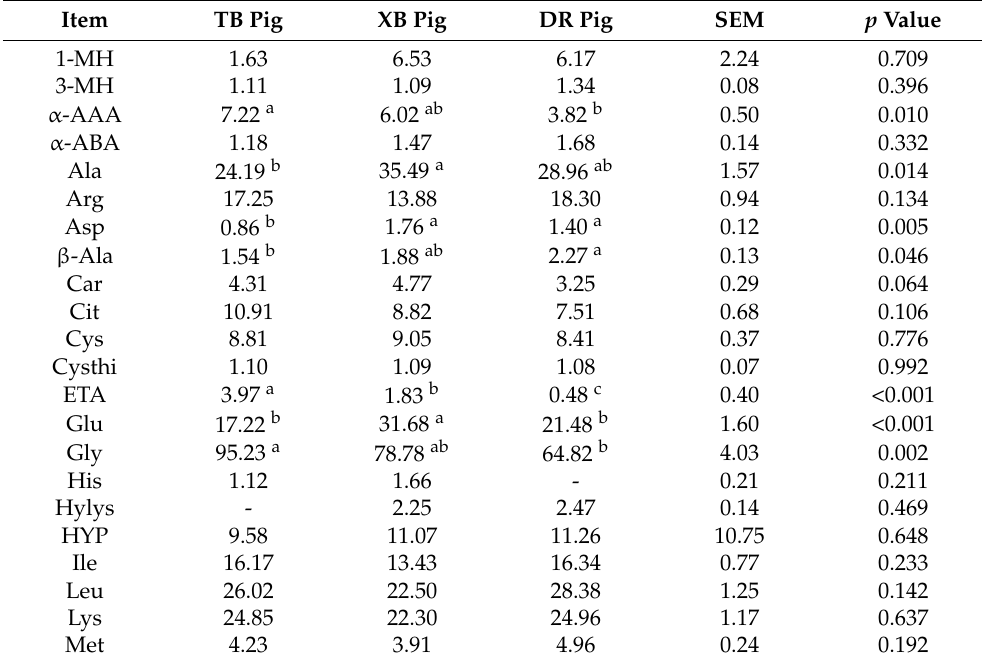
Table 6. Plasma free amino acids composition of three pig breeds at 125 days of age ( µ